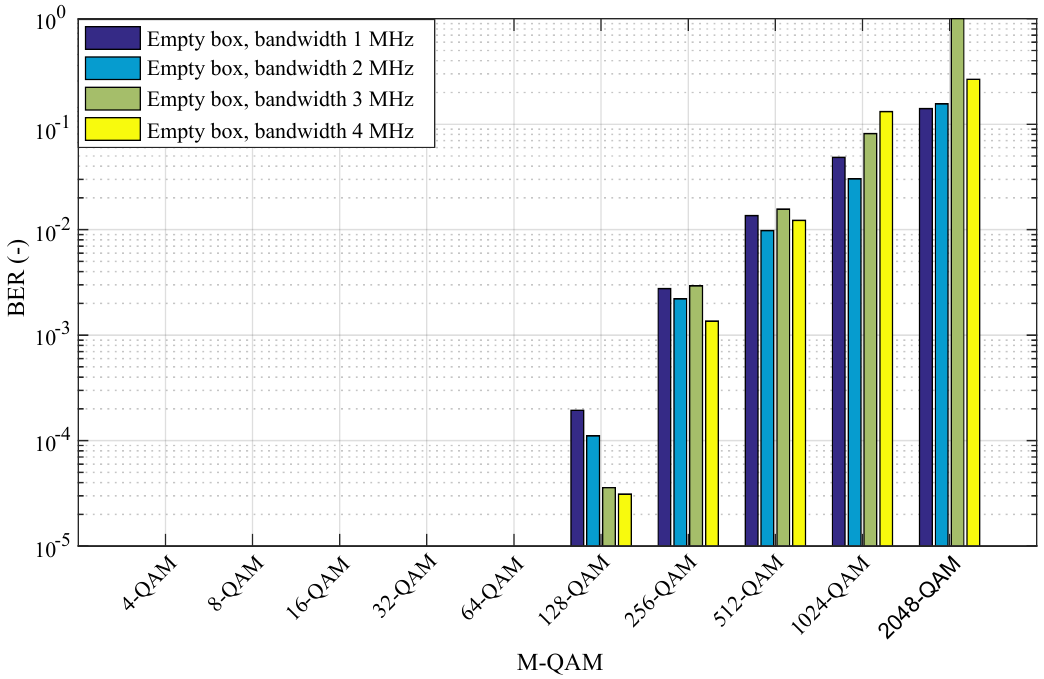
Figure 15. BER/distance relationship for Octavia tail-light with different M-QAM and bandwidths —scenario 1—empty box.